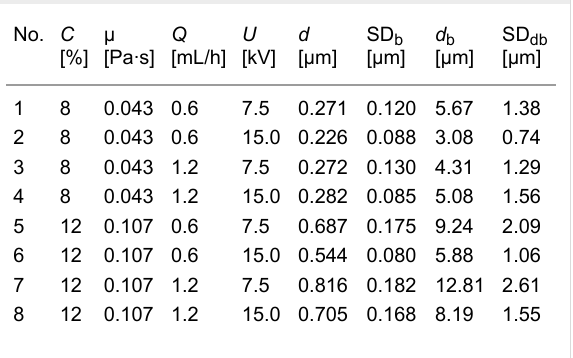
Table 8: Experimental variants for a 2 3 factorial design including the average diameter of obtained beads ( d b ) and average diameter of beaded fibers ( d ). SD b is the standard deviation of d and SD db is the standard deviation of d b